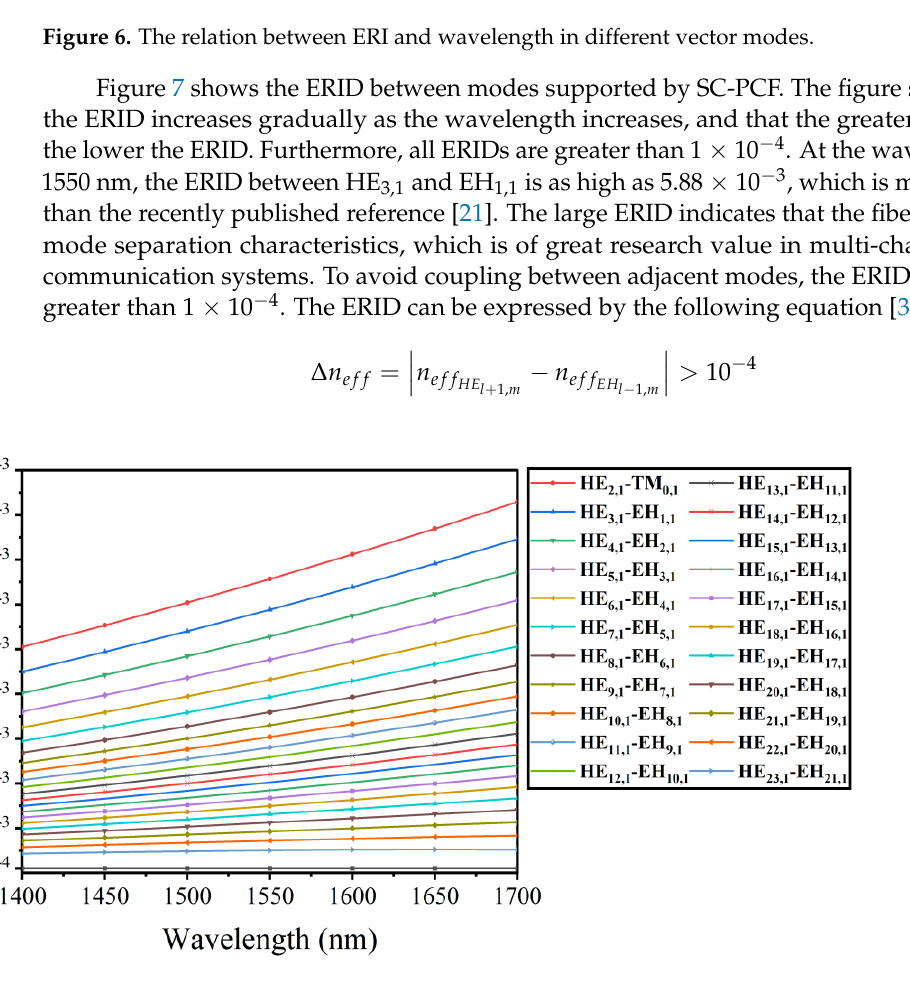
Figure 7. The relation between ERID and wavelength in different vector modes.